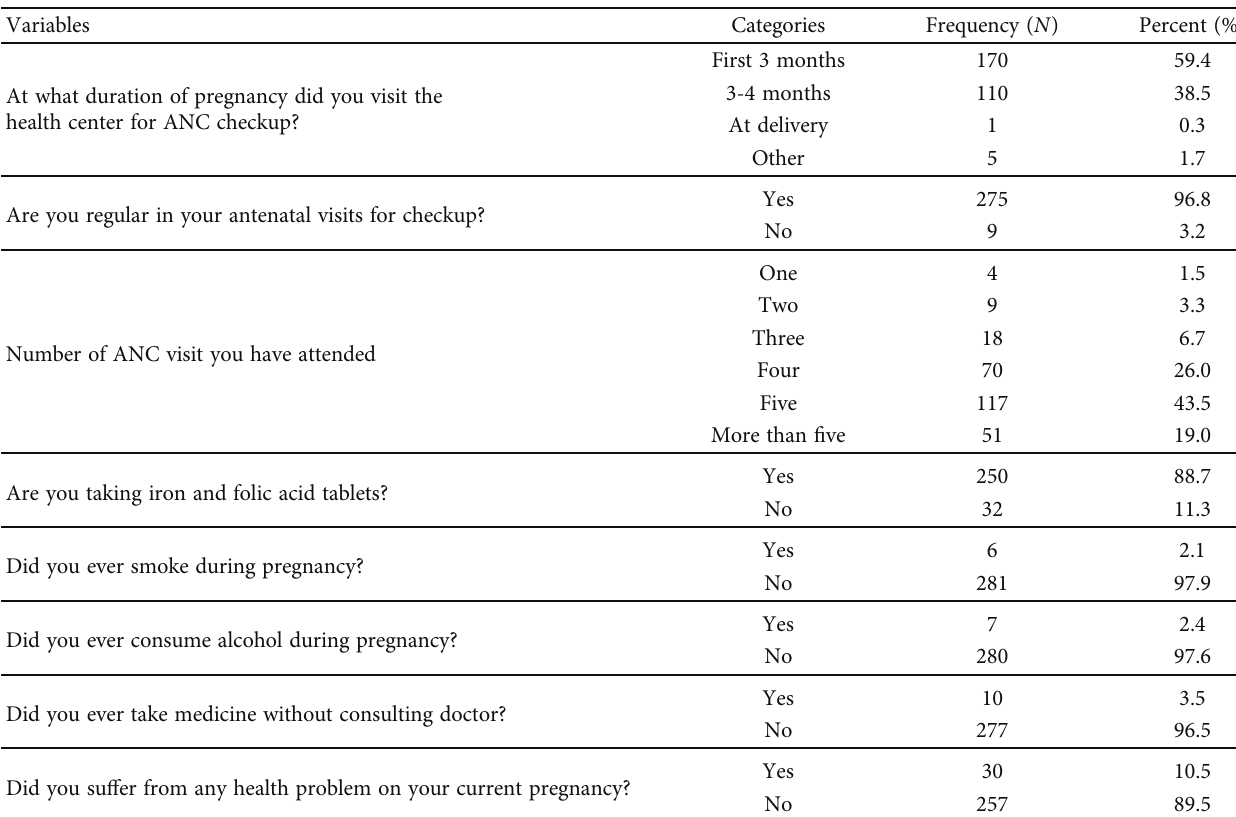
Table 4: Practice of pregnant mothers on antenatal care in Amatere Health Center, Massawa, Eritrea ( N = 289